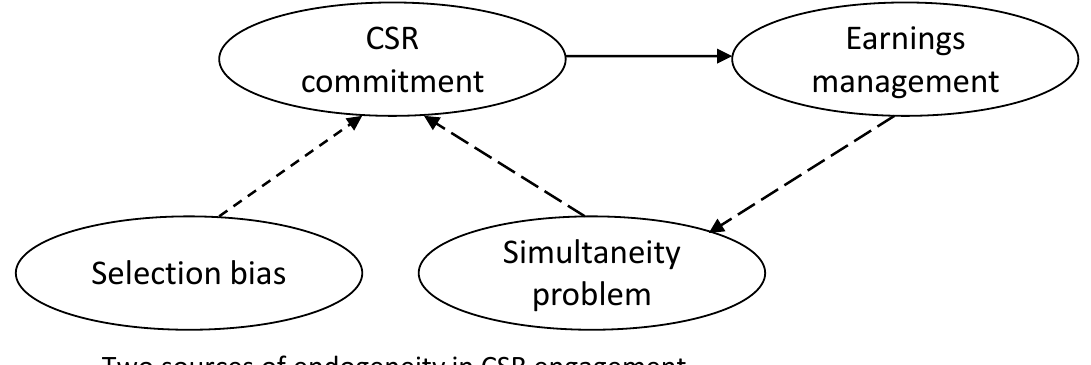
Figure 2. Endogeneity concerns in CSR